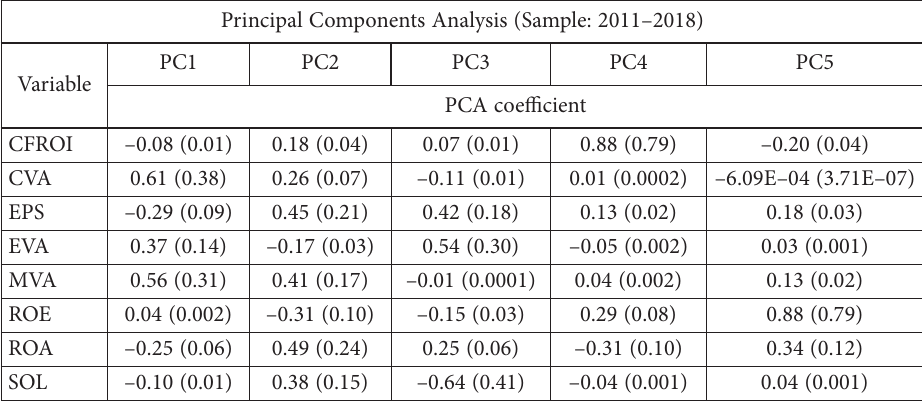
Table 3. Eigenvectors of the principal components (source: authors’ calculation using EViews 9) Principal Components Analysis (Sample: 2011–2018)